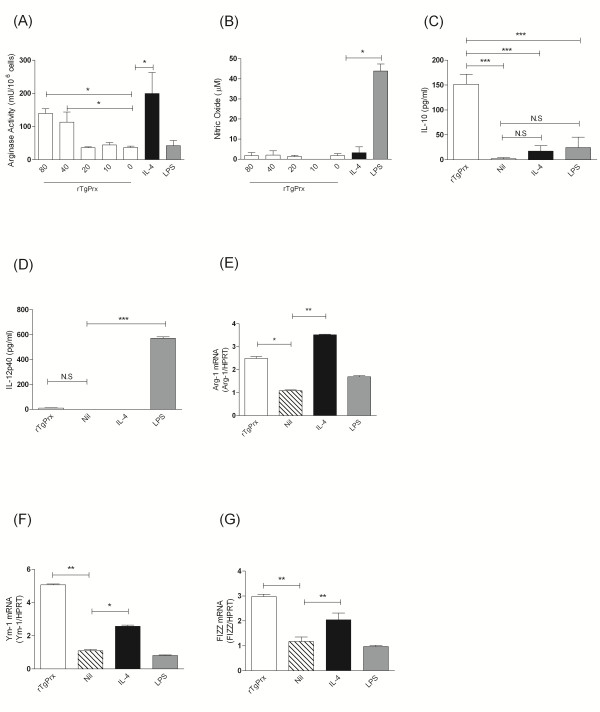
Activation of murine macrophages by rTgPRX. Cells were stimulated for 24 h under the indicated conditions and then analysed. (A) Cell lysates were tested for arginase activity by enzyme assay. (B) NO was measured in the supernatants from the same cultures as in (A). IL-12p40 (C) and IL-10 (D) were measured by ELISA in supernatants. PCR (E - G) was performed on cell 16 h after stimulation for FIZZ (E), Ym1 (F), and Arg-1 (G). rTgPrx at 80 μg/mL was used in panels (b), (c), and (d). p < 0.05 and ***p < 0.001, values represent a mean of triplicate wells ± SD; experiments were repeated three times with similar results.